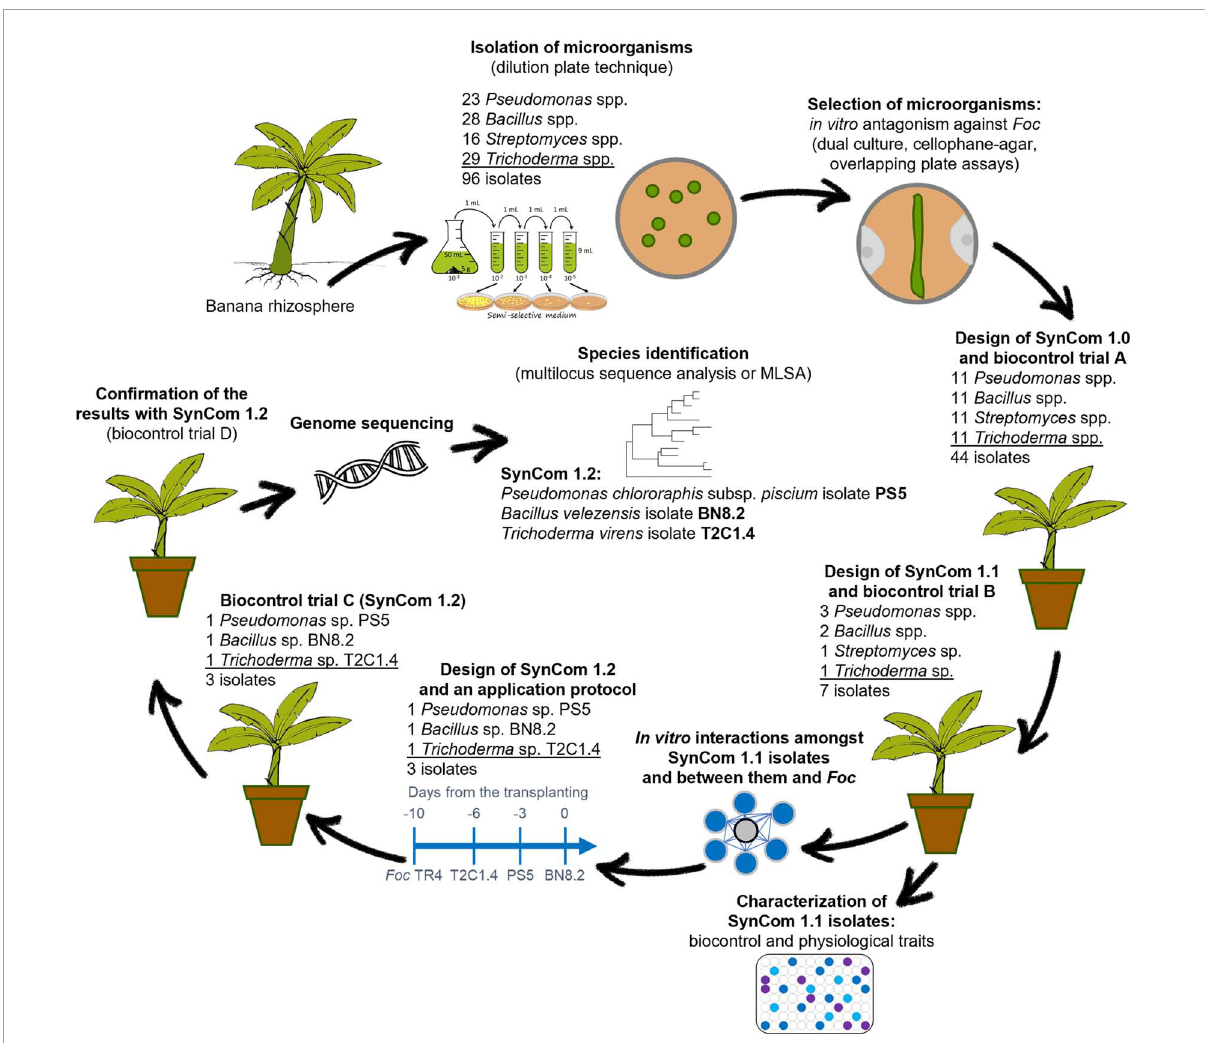
FIGURE1 Schematic representation of the steps of our research which led to the development of a synthetic microbial community namely SynCom 1.2 effective against Fusarium oxysporum f. sp. cubense ( Foc ) tropical race 4 (TR4) starting from the isolation of microorganisms from the banana